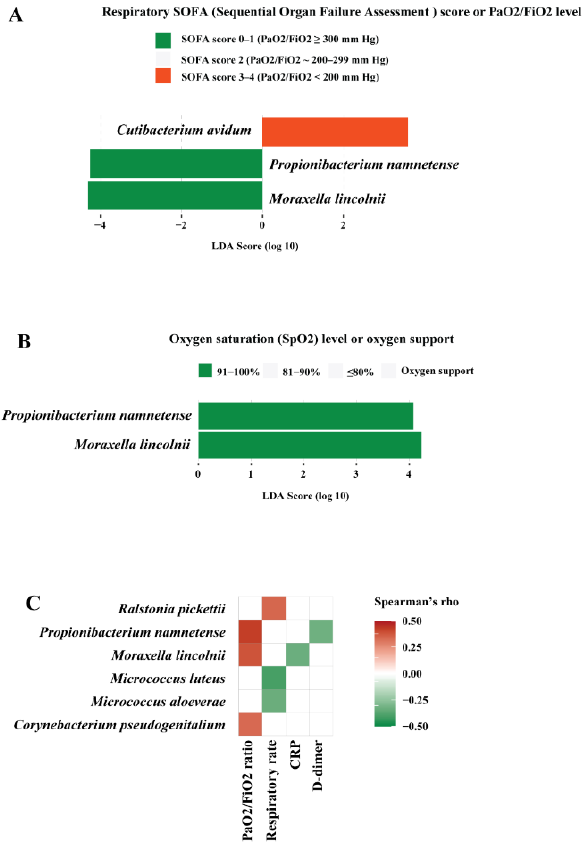
Figure 3. Bacterial microbiota in correlation to clinical outcomes in COVID-19 patients. ( A ) Bacterial species biomarkers associated with respiratory SOFA (Sequential Organ Failure Assessment) score or PaO2/FiO2 level. ( B ) Bacterial species biomarkers associated with oxygen saturation (SpO2) level or oxygen support. The biomarkers were identified by linear discriminative analysis (LDA) effect size (LEfSe) analysis. LDA scores (log 10) for the enriched species in a given group are represented with colors as shown. The LEfSe alpha value was set at 0.05, the threshold used to consider a discriminative feature for the LDA score was set at >2. ( C ) Correlation between bacterial species and markers of respiratory and inflammatory status. Spearman’s correlation rho values are represented by color gradient as indicated (red is for positive, green is for negative correlation). Only correlations with p < 0.05 are shown on the